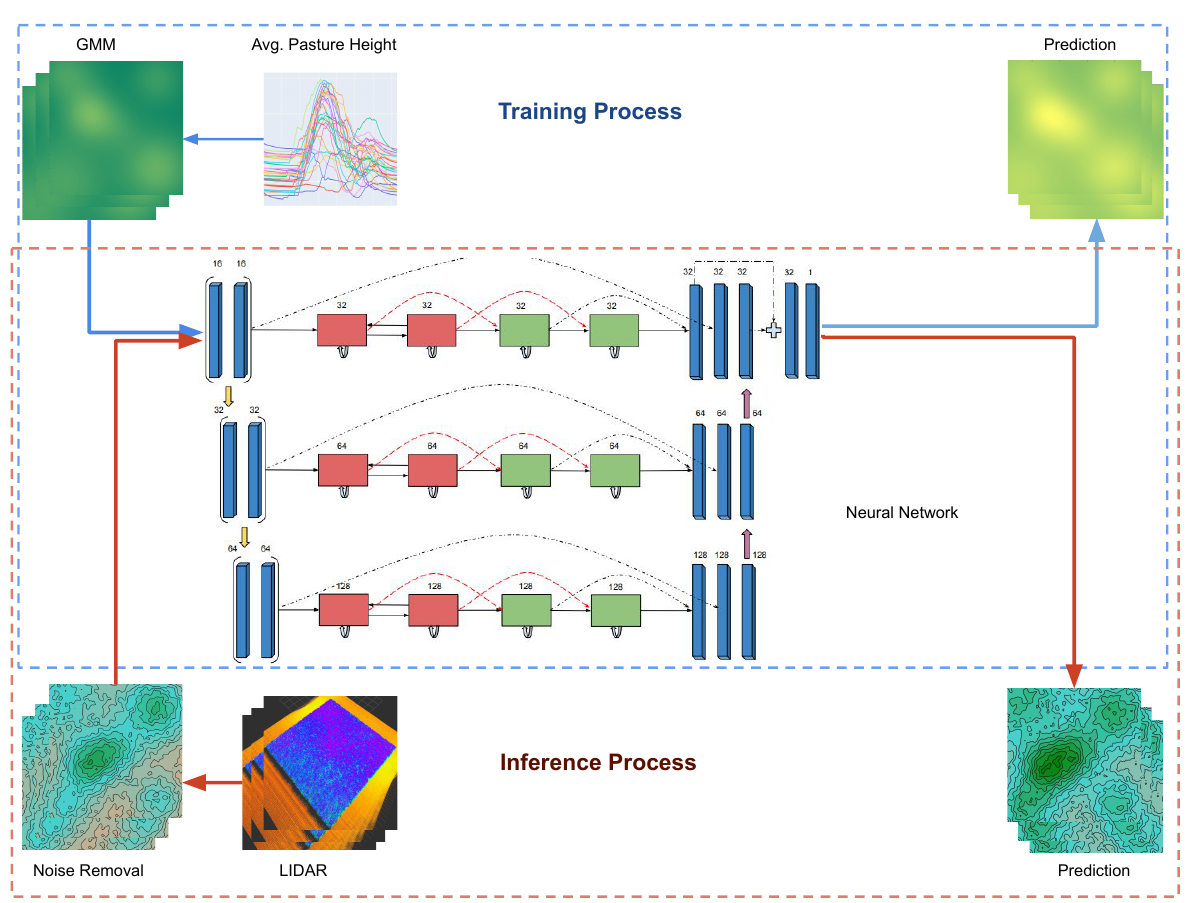
Figure 5. Process for training and inference of DeepPaSTL. Synthetic training datasets are created using GMM models based on the average pasture heights of Iowa sites. Real world field measurements can be obtained by using LIDAR point cloud measurements. The point cloud data are then processed to smooth out sensor noise and then DeepPaSTL is used to predict future pasture